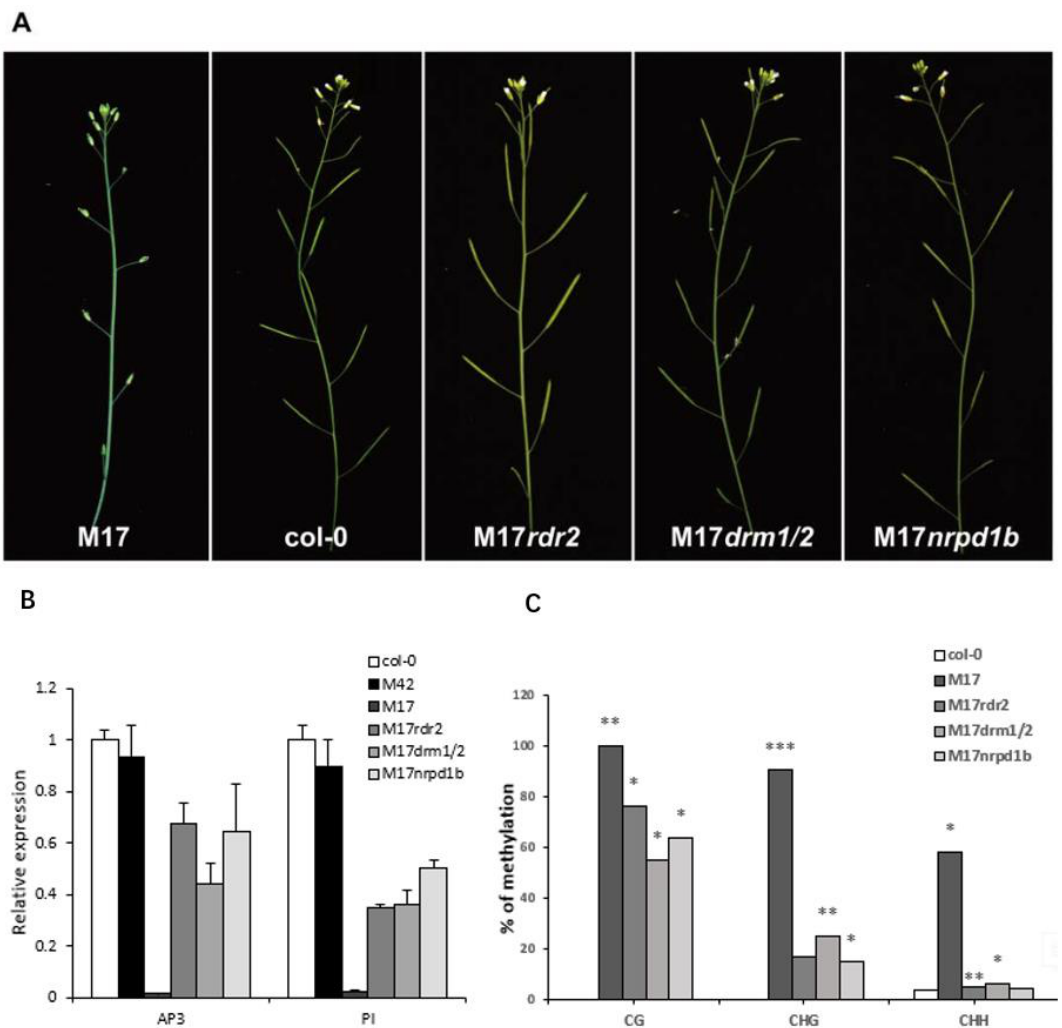
Figure 5. Complementation test for M17 transgenic lines. ( A ) All the morphological defects including sepaloid petals and absence of anthers in M17 were rescued in complementation lines; ( B ) RT-PCR analysis of the expression of AP3 and PI in M17 and complementation lines; ( C ) cytosine DNA methylation analysis of transgenic, which is endogenous AP3 promoters in M17 and complementation lines by bisulfite sequencing and T test analysis of methylation di ff erences in the group (* p < 0.05, ** p < 0.01, *** p < 0.001). The expression levels were controlled using the signal from the ACTIN gene. The average ( ± SD) values are shown from three biological duplicates of quantitative reverse transcription PCR.